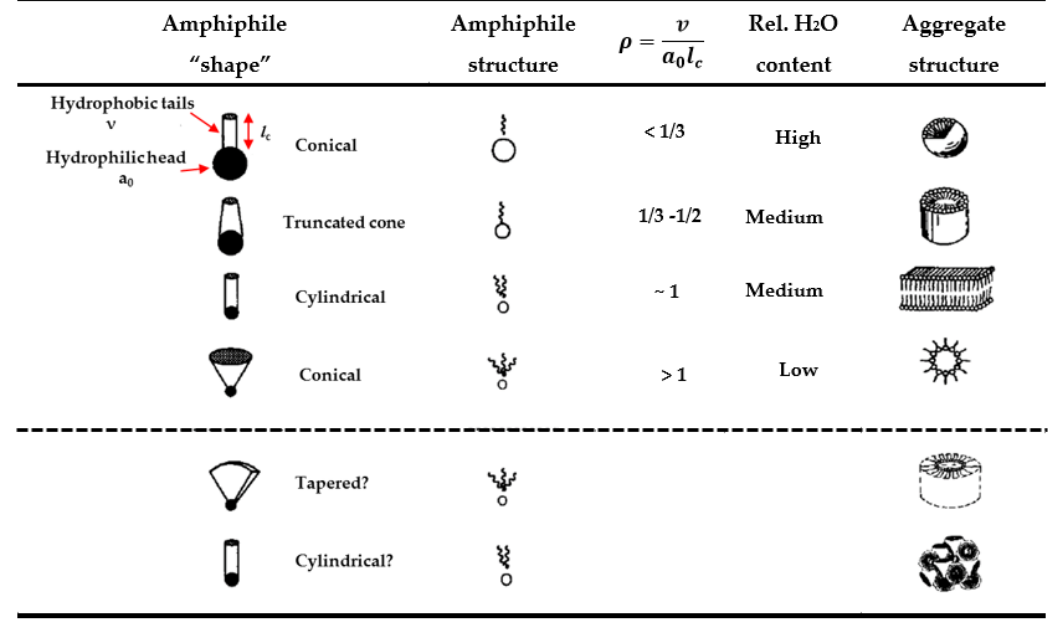
Figure 5. Relationships between the structural dimensions of surfactant molecules and their preferred aggregates according to the Israelachvili Model [31] (Adapted with permission from [31], copyright Elsevier, 1985).